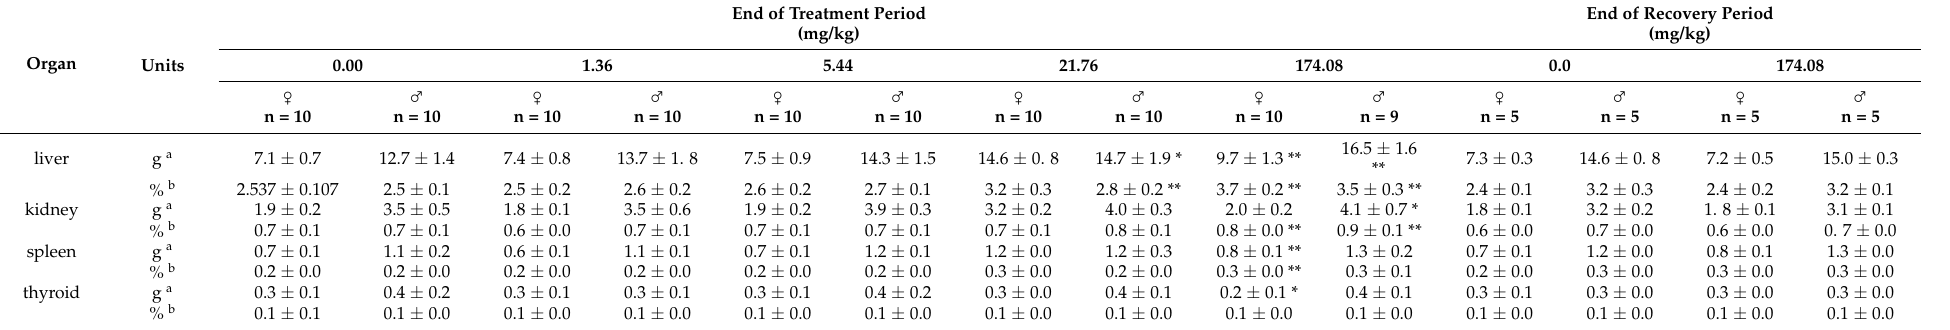
Table 4. Absolute and relative (to body weight) organ weights of SD rats orally administered AQ for 90